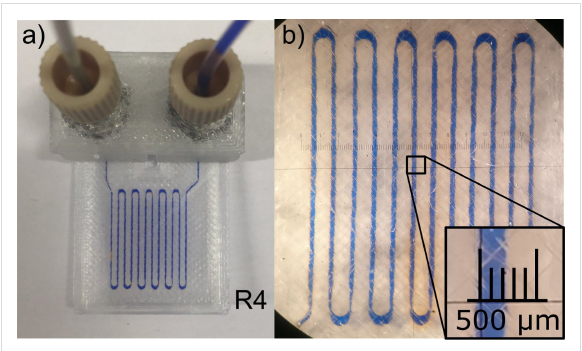
Figure 3: a) Microreactor R4 with a reactor volume of 12 µL filled with a blue dye solution. b) Magnification of the reactor channels, which shows a width of ≈ 200 μ